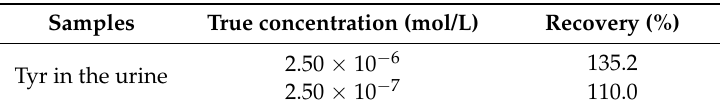
Figure 8. (a) SERS spectra of azo dye with various concentrations of Tyr; (b) Highlighted SERS spectra range of Tyr-derived azo dye with various concentrations at 1432, 1393, and 1142 cm −1 ; and, (c) Correlation between the intensities of three typical peaks of Tyr-derived azo dye at 1432, 1393, and 1142 cm −1 and Tyr concentration. Table 1. Recovery test of Tyr in the